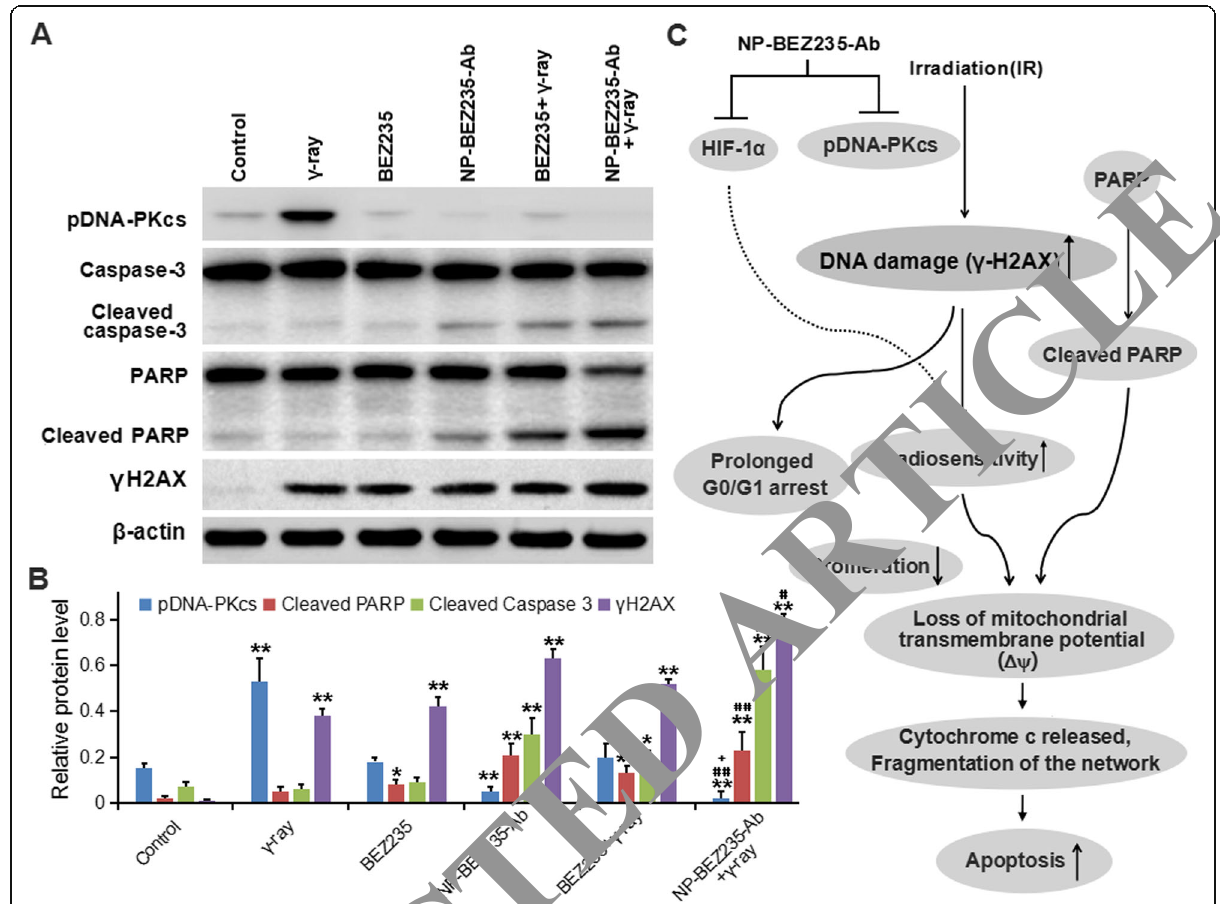
Fig. 9 The role of NP-BEZ235-Ab in apoptosis-related proteins in each HepG2 cells. a Western blots of cellular extracts from HepG2 cell line in each group. Lysates were probed with antibodies against pDNA-PKcs, γ H2AX, the cleaved form of caspase 3, and PARP. b Protein levels of γ H2AX, the cleaved form of caspase 3, and PARP in the groups. c Diagram of the hypothetical effects of NP-BEZ235-Ab on the apoptosis and proliferation in HepG2 cells. Each value represents the mean ± SD of three independent experiments. * p < 0.05, ** p < 0.01 versus control group. # p < 0.05, ## p < 0.01 versus γ -ray or BEZ235 group. + p < 0.05, ++ p < 0.01 versus NP-BEZ235-Ab or BEZ235 + γ